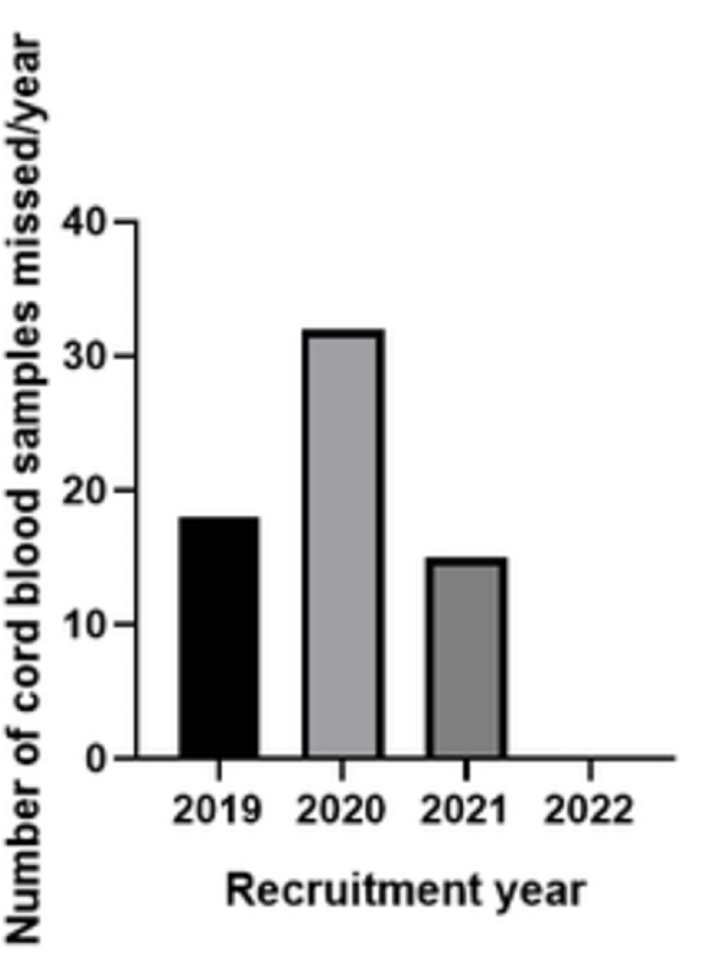
Fig 3. Number of cord blood samples missed over the period of